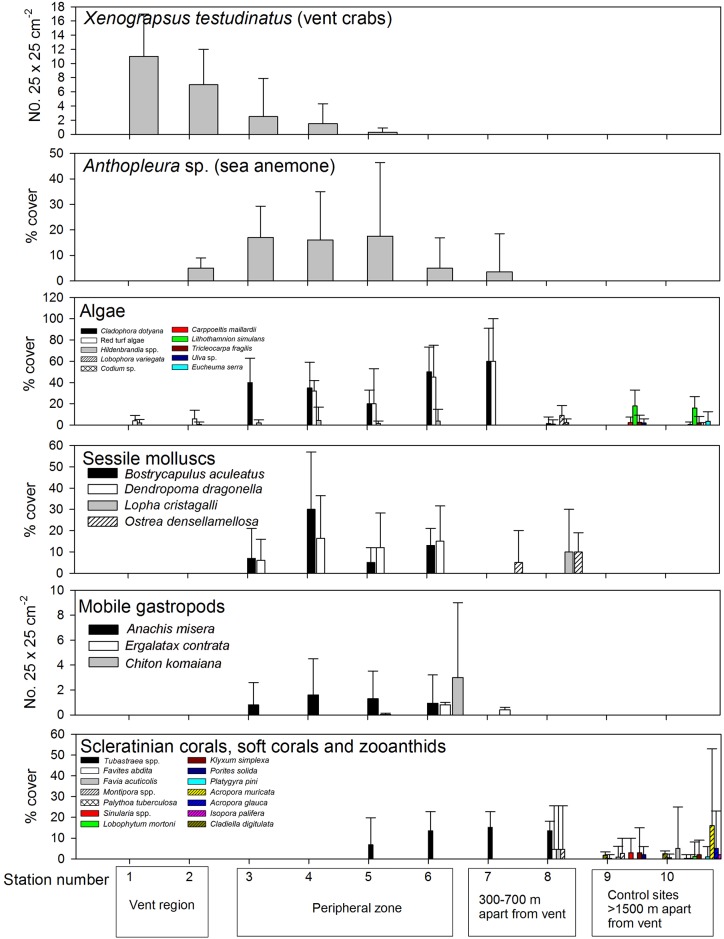
Variation in mean (±1 SD) abundance of major species recorded by transect surveys in Stations 1–8.Species with their maximum mean abundance from all stations < 1 individuals per quadrat or 1% cover were not shown. See S2 Table for a complete list of the species recorded in all stations. Note the red turf algae contains mixture of including Ceratodictyon repens, Chondracanthus intermedius and Pterocladilla sp. which cannot be identify separately in the in-situ quadrat photographs.